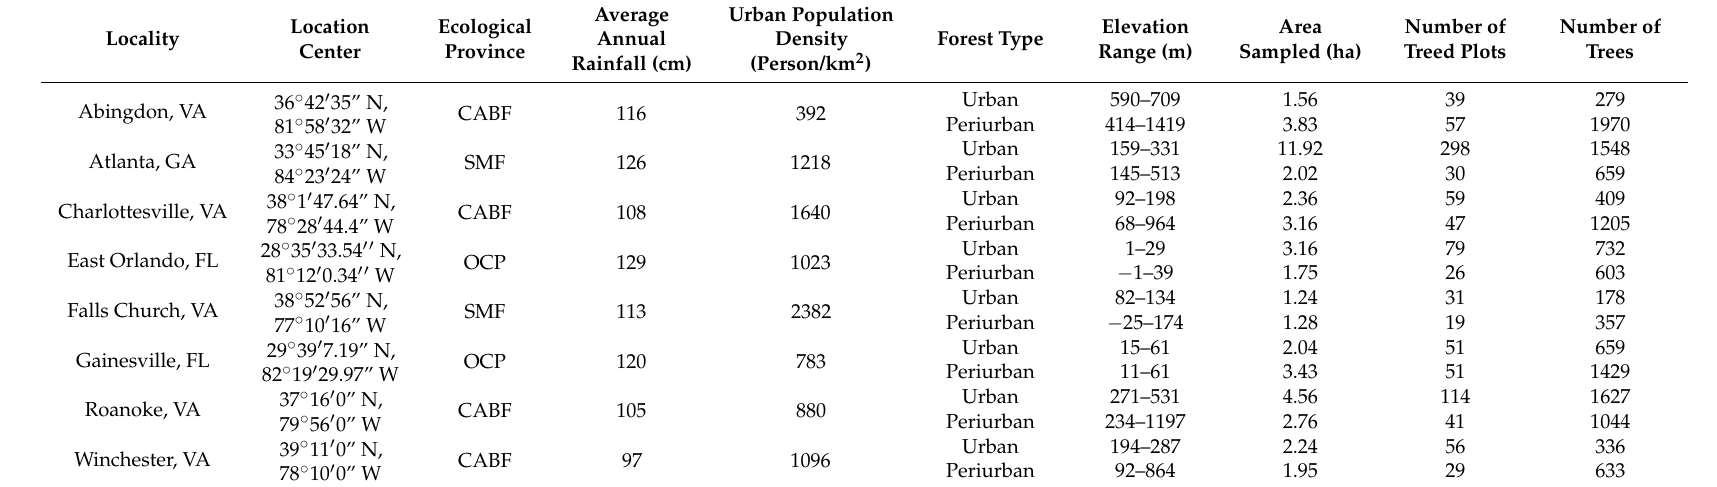
Table 1. Locality and plot characteristics for sampling locations and urban* and periurban** forest types in the southeastern US study area. Numbers of trees were not expanded to reflect lower sampling intensities in periurban microplots. Ecological province was defined by USDA Forest Service ecozones [38]. Population density is from 2010 U.S. Census Data [39]. CABF = Central Appalachian Broadleaf Forest-Coniferous Forest-Meadow, SMF = Southeastern Mixed Forest, OCP = Outer Coastal